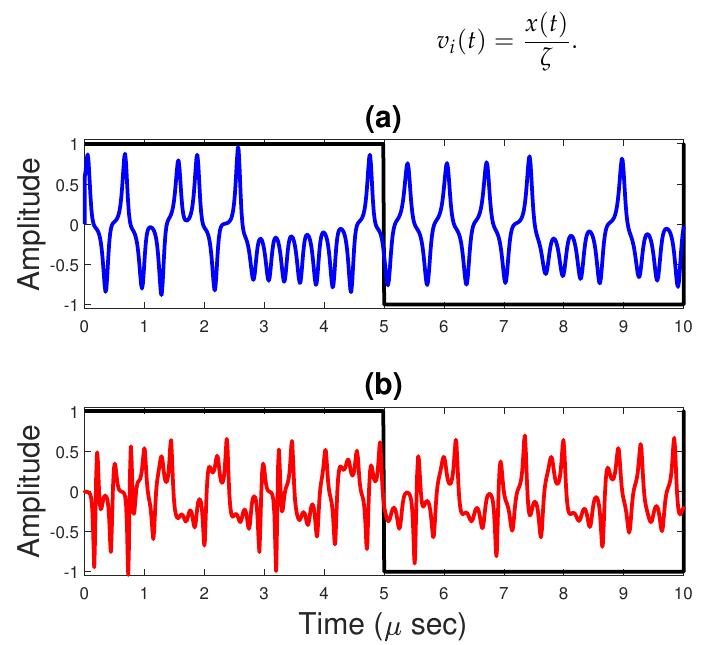
Figure 2. Instantaneous frequency ( v i ( t ) is the scaled version of x ( t ) ) of the CBFM waveform using ( a ) Lorenz and ( b ) Burke–Shaw chaotic systems (zoom in plots). The solid line indicates the encoded information. The time-series plot does not have any discontinuities when digital information is